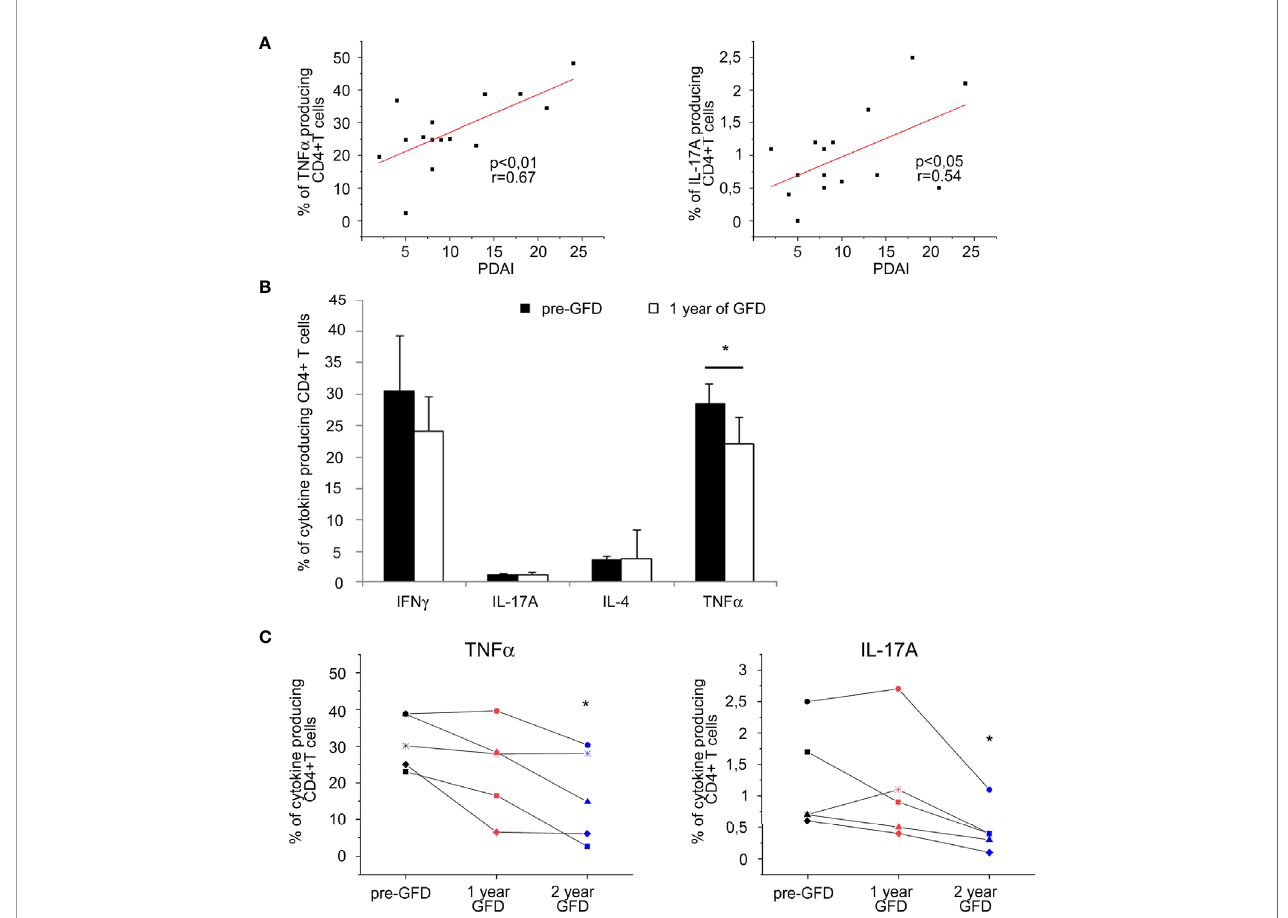
FIGURE 2 | PB Cytokine-producing T cells frequencies correlation with disease activity score and evaluation after gluten free diet in DH patients. (A) Correlation between disease activity score PDAI and frequencies of circulating CD4+ T cells producing TNF a (left panel) and L-17A (right panel) was calculated in 15 DH patients. (B) Frequencies of intracellular cytokines producing CD4+ T cells in fresh samples from PB were evaluated in 8 DH patients before and after 1 year of gluten free diet (GFD). Columns represent means ( ± SE) of the indicated cytokine. *p ≤ 0.05. (C) Frequencies of circulating CD4+ T cells producing TNF a (left panel) and IL-17A (right panel) in fresh samples from PB were evaluated before (To) and after 1 and 2 year of gluten free diet (GFD) in 5 DH patients. ( ± SE). *p ≤ 0.05 compared to the To